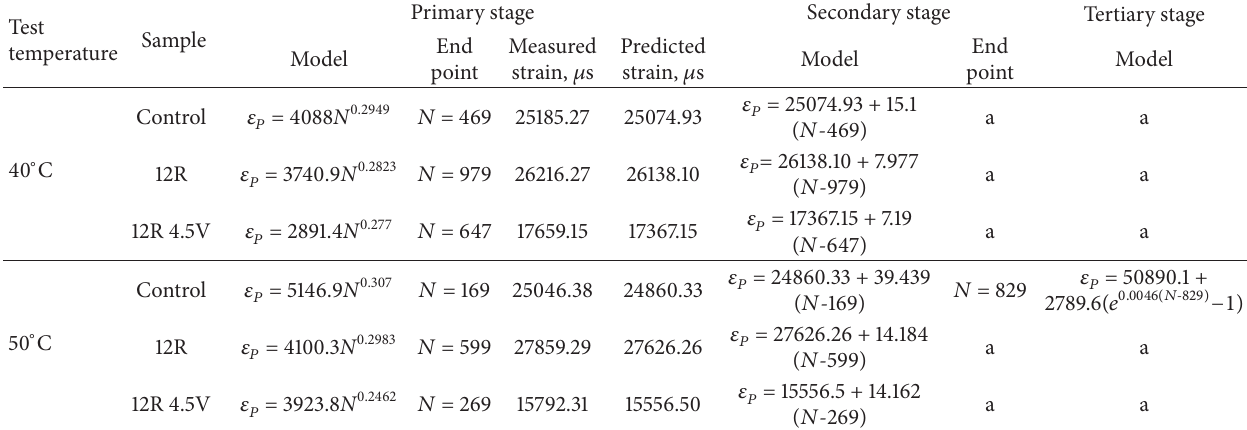
Table 8: Three-stage models and boundary points for control and modified mixtures at 400 kPa